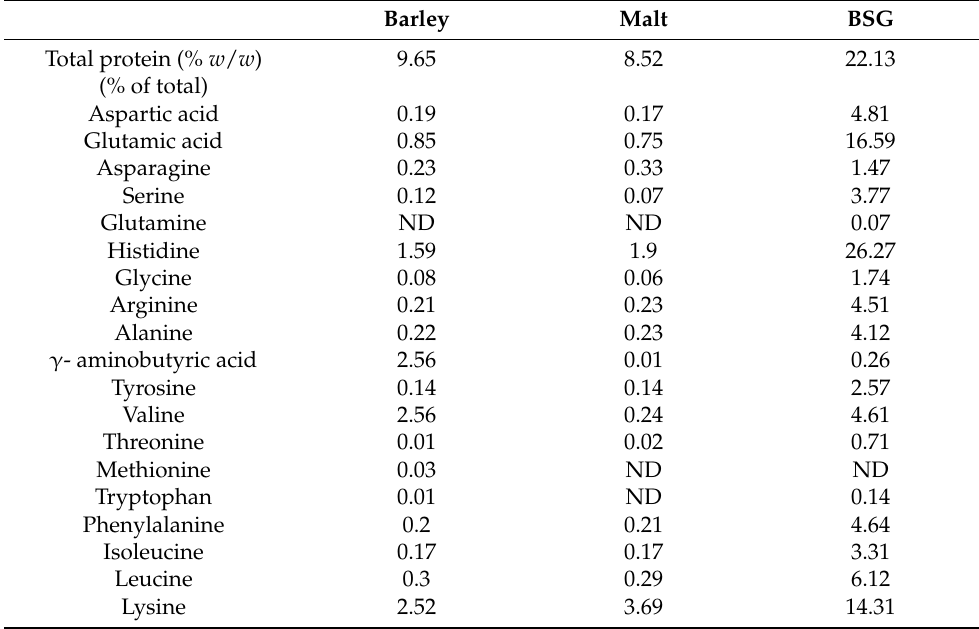
Table 1. Amino acid composition of barley, barley malt and BSG—adapted from Waters et al. (2012). Barley Malt BSG Total protein (% w / w